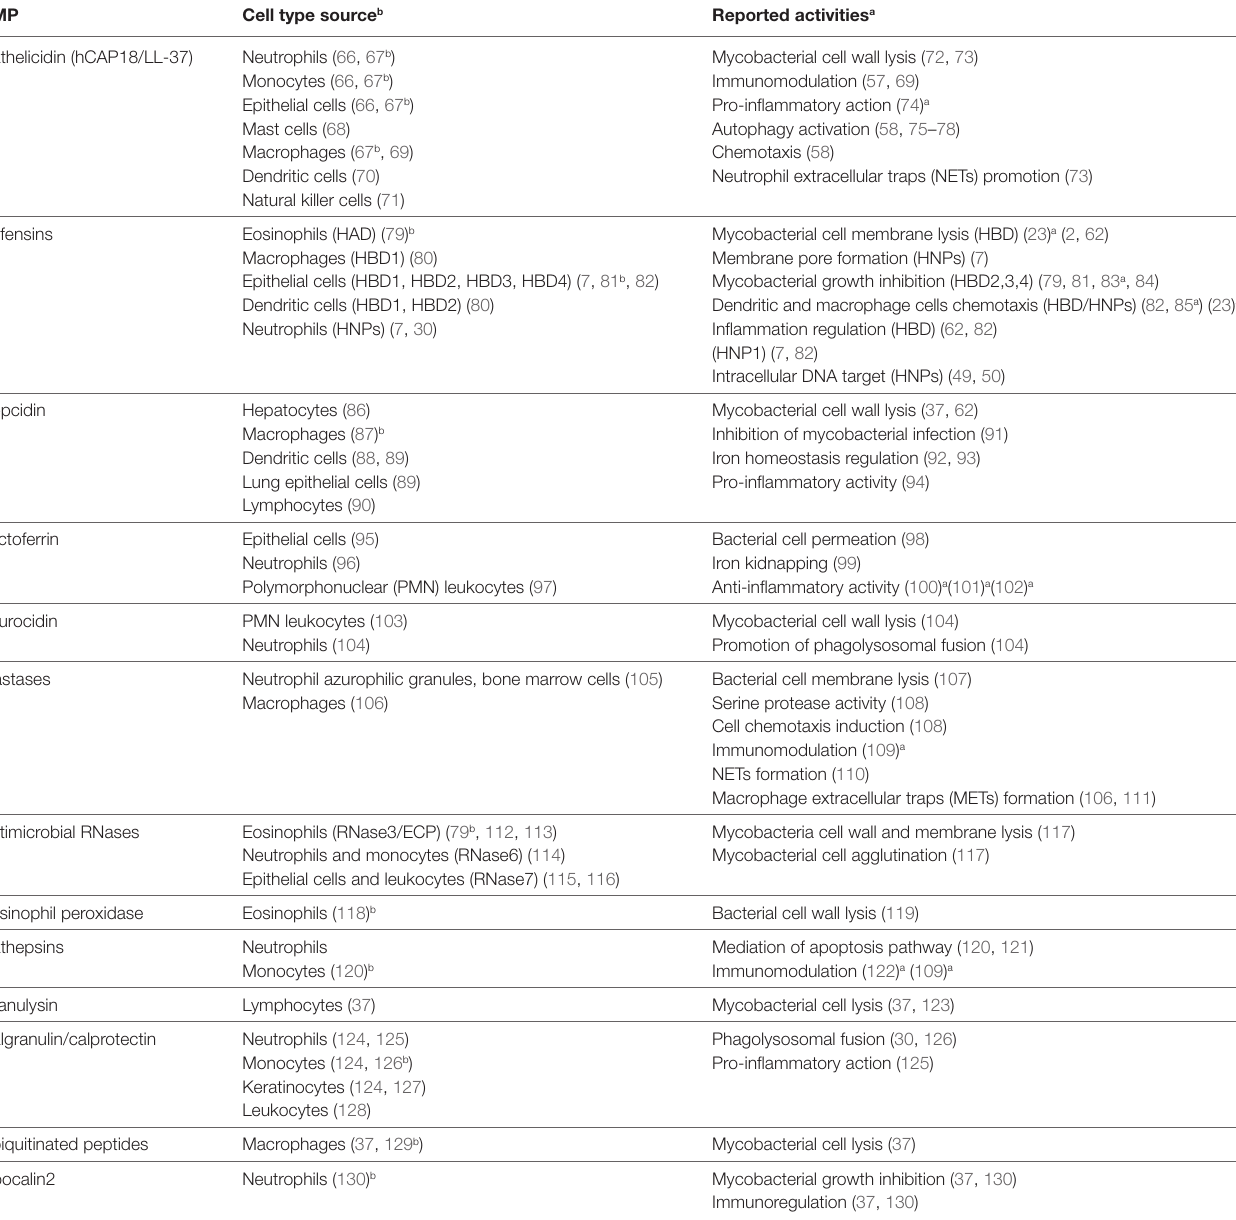
TABLe 1 | Human AMPs involved in immune host defense against